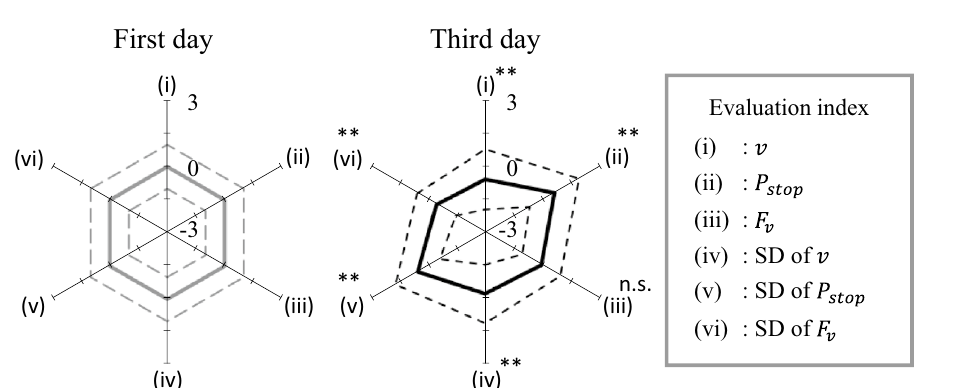
Figure 6. Radar chart for the evaluation indices before and after ethanol